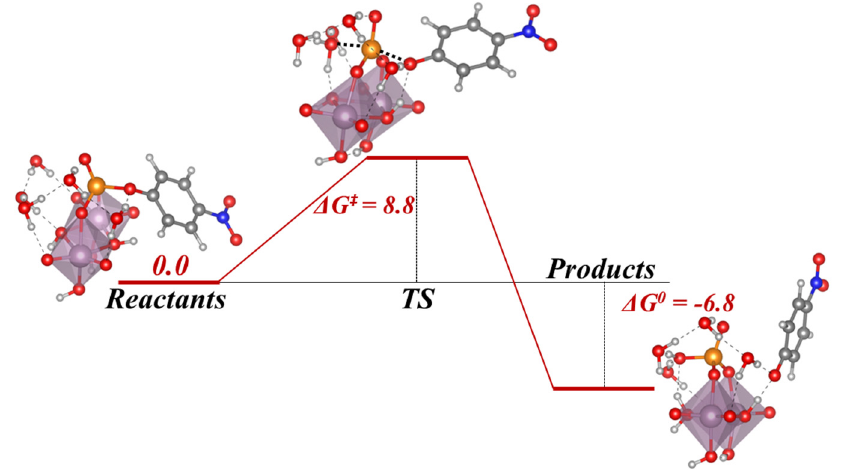
Figure 37. Mechanism of reaction for the pNPP hydrolysis activated by the [Mo 2 O 8 H 4 ] 0 species where the O bridge atoms are protonated along with the axial O atoms. Four explicit H 2 O molecules are considered. The Gibbs free energies are in kcal mol − 1 .